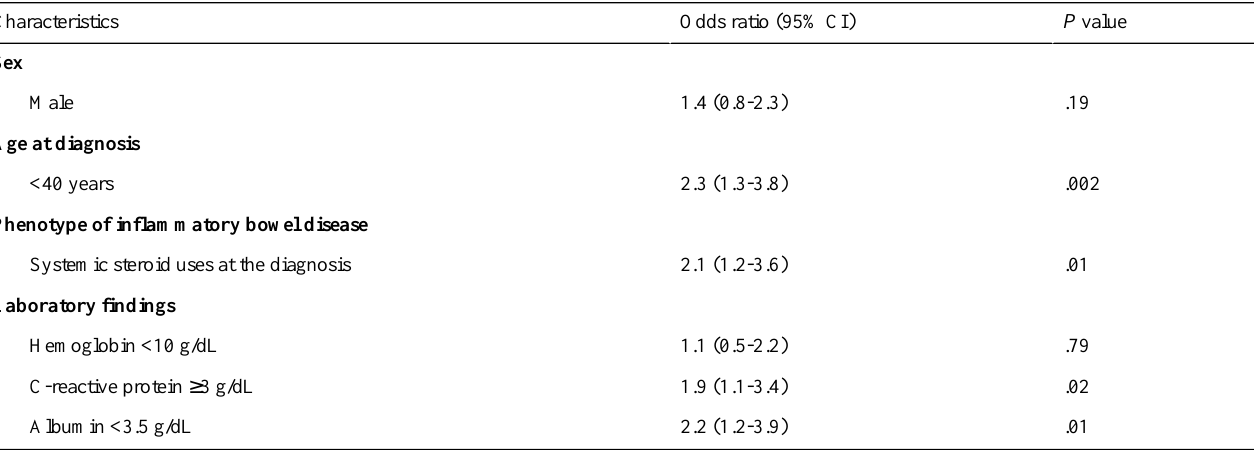
Table 4. Multivariate analysis for the detection of associative valuables with experience of biologic agent in ulcerative colitis.